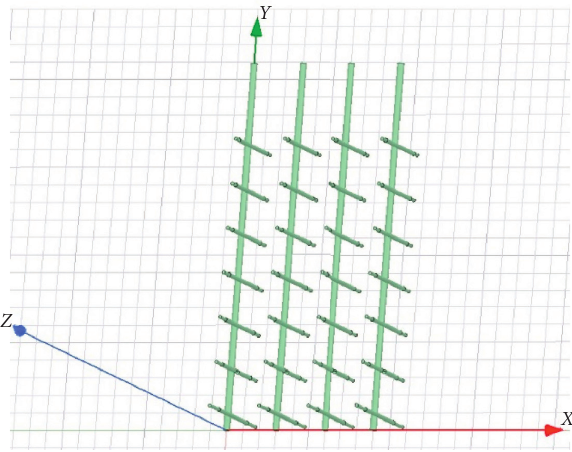
Figure 3: The 4 Yagi–Uda antenna array model. Each antenna has 7